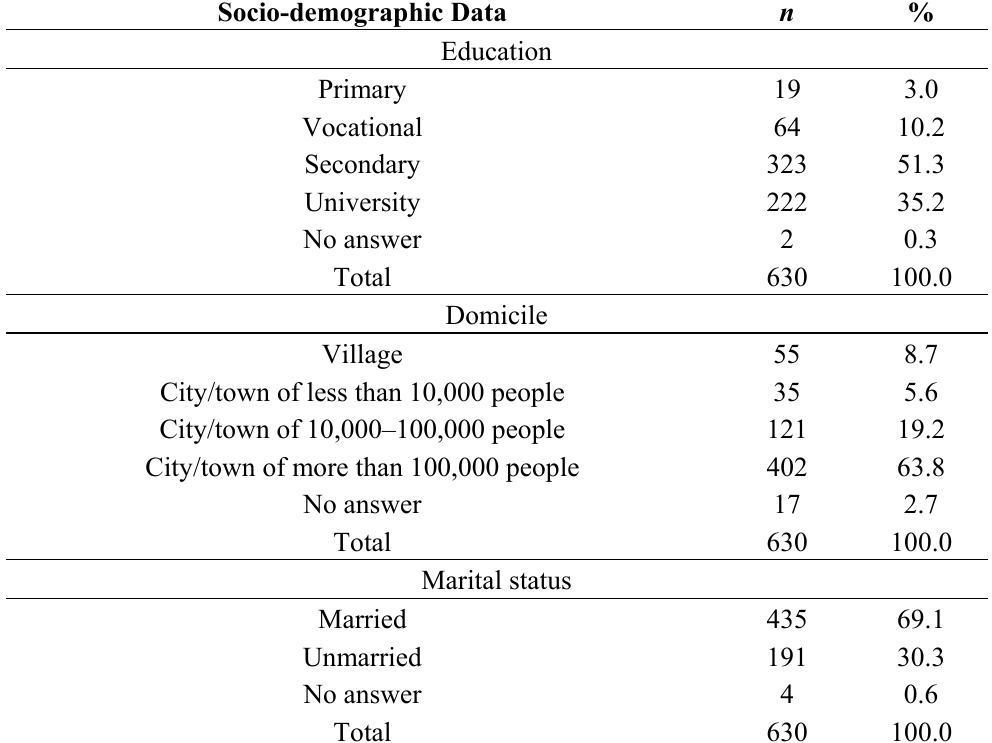
Table 1. Group structure according to socio-demographic and medical data of